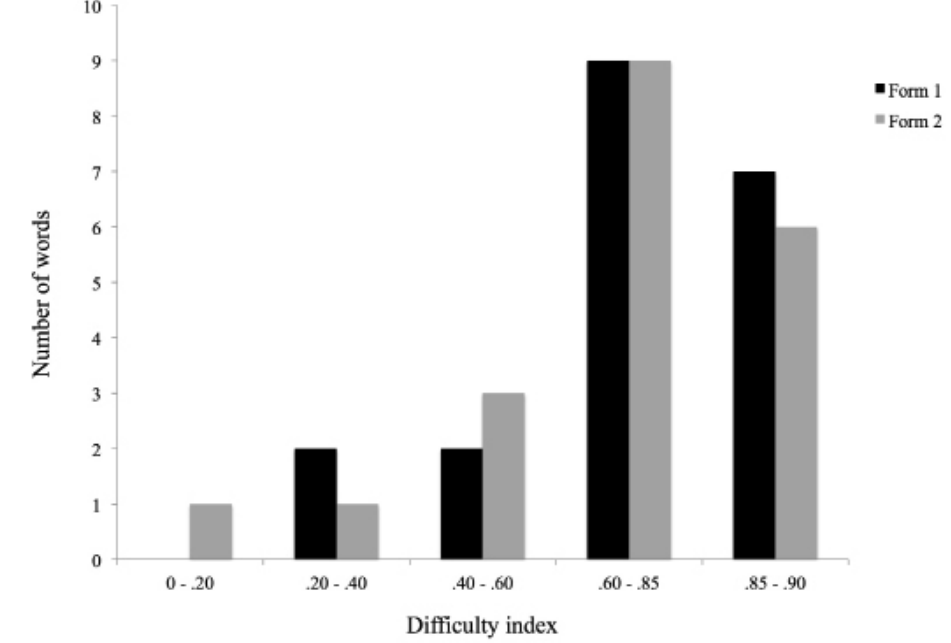
Figure 2 . Distribution of words on both subtests forms by level of dif fi culty [very high ( p < .20), high (.20 ≤ p < .40), average (.40 ≤ p < .60), easy (.60 ≤ p < .85), very easy (.85 ≤ p <